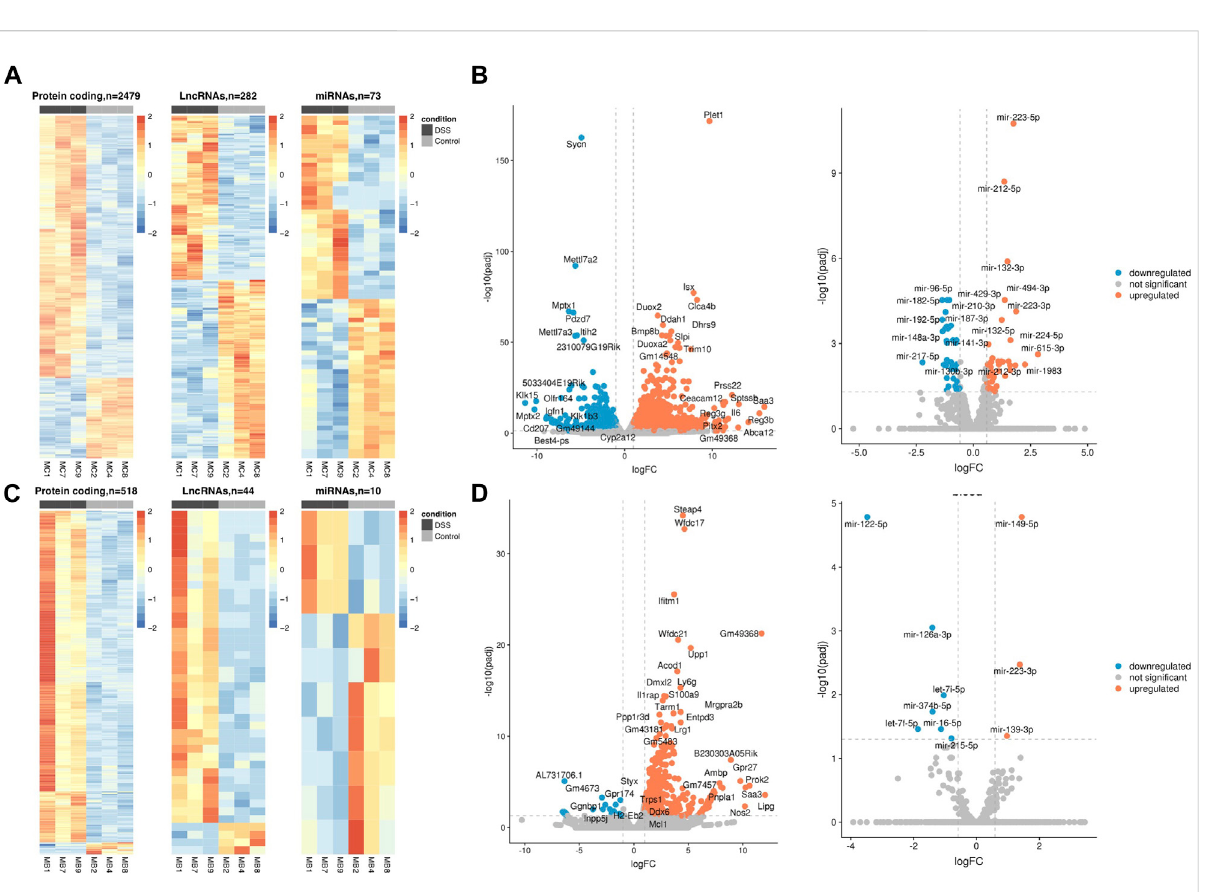
FIGURE 1 DSS-UC mouse transcriptional signature. Heatmaps of SDE PCGs, lncRNAs, and miRNAs, based on z-scores of normalized log counts for (A) colon and (C) blood. Volcano plots log2FC ratio on the x-axis versus -log10 padj on the y axis for colon (B) and blood (D) . (UC, n = 3 and CO, n =